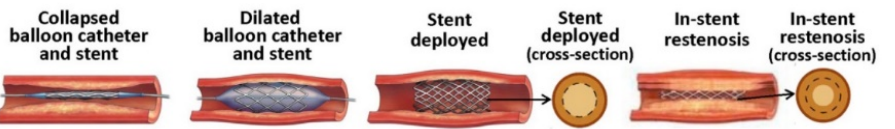
Figure 2. In ‐ stents coronary restenosis after coronary angioplasty with the bare metal stents, repro ‐ duced with permission from [3] .